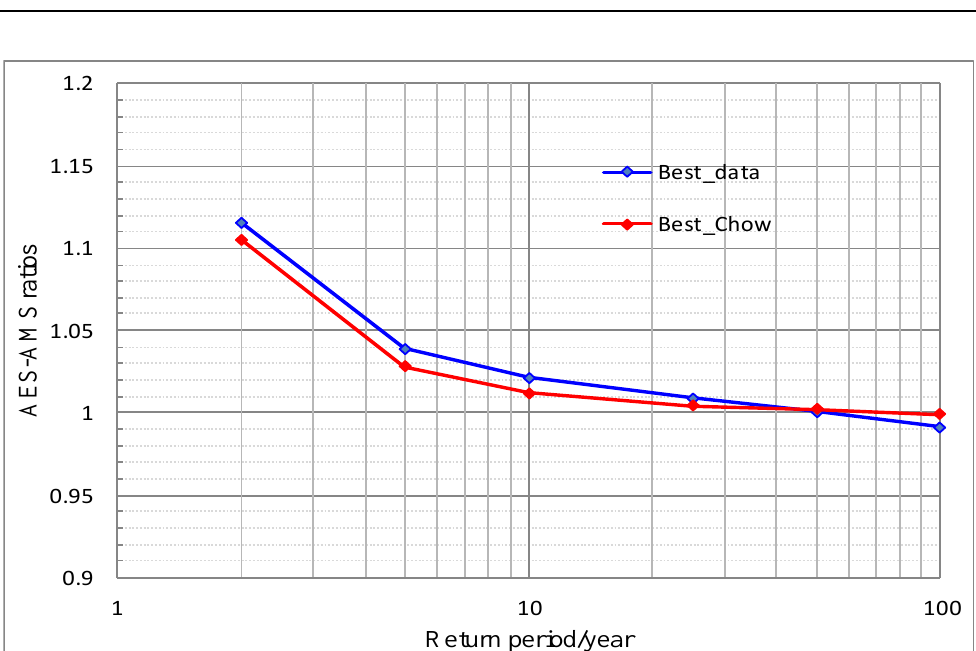
Figure 3. Comparison of AES–AMS ratios obtained using Chow’s equation and real data. Taking Region I as an example, quantile estimates based on AES data, AMS data, and Chow’s equation are shown in Table 4. The results from region II, III, IV, and V can be found in Table S2 in Supplementary Material. The frequency estimates obtained from